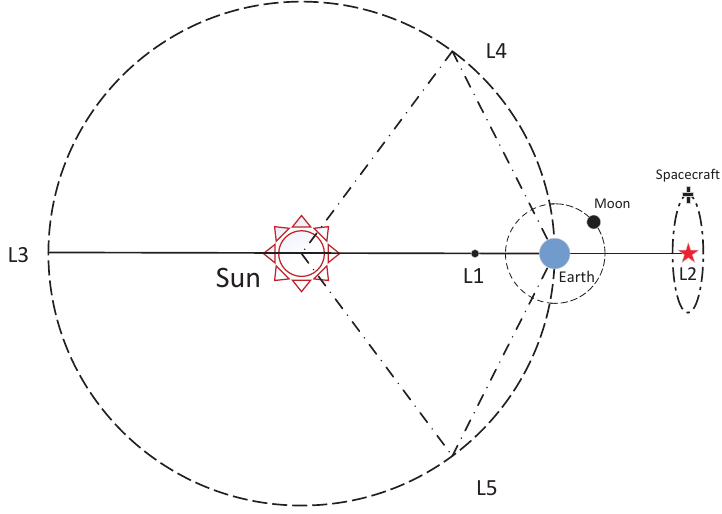
Figure 2. Schematic diagram of Lagrange point between the Sun and the Earth.